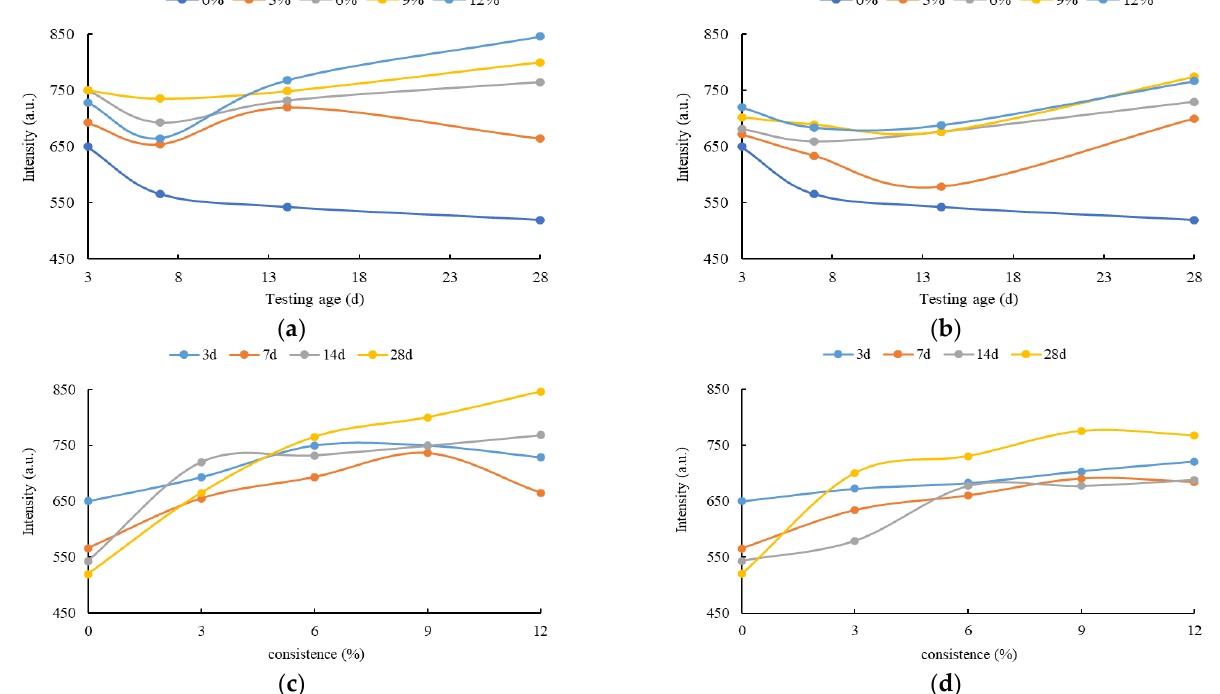
Figure 6. The diffraction peak intensity of CH crystals: ( a ) IN; ( b ) OU; ( c ) IN; ( d ) OU